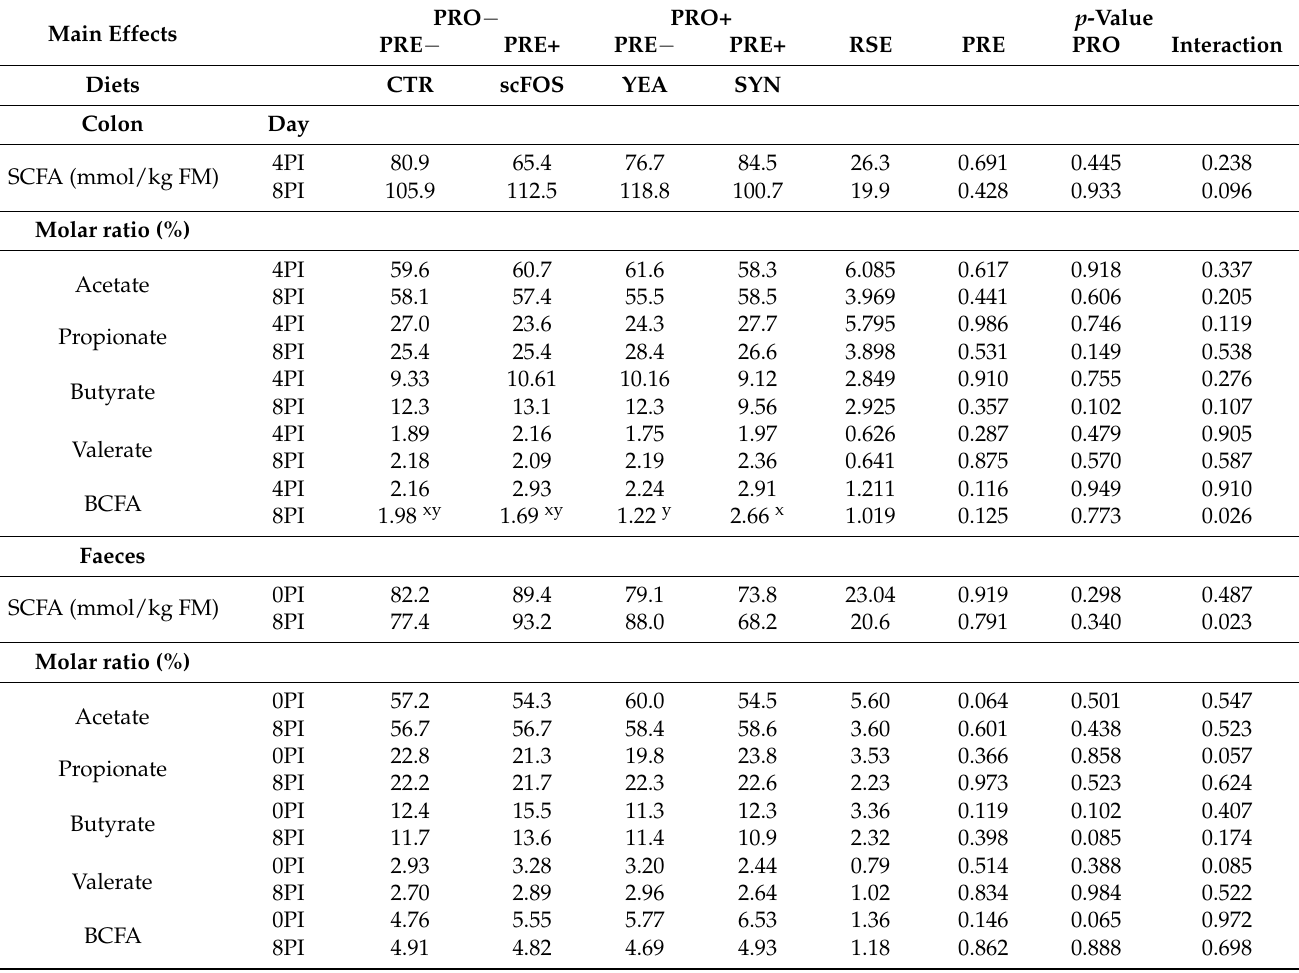
Table 6. Effect of experimental treatments on colonic and fecal fermentation. Table includes total short-chain fatty acids (SCFA) (mmol/kg of FM), as well as molar ratio of their components. Values are given for days 4 and 8 post inoculation.